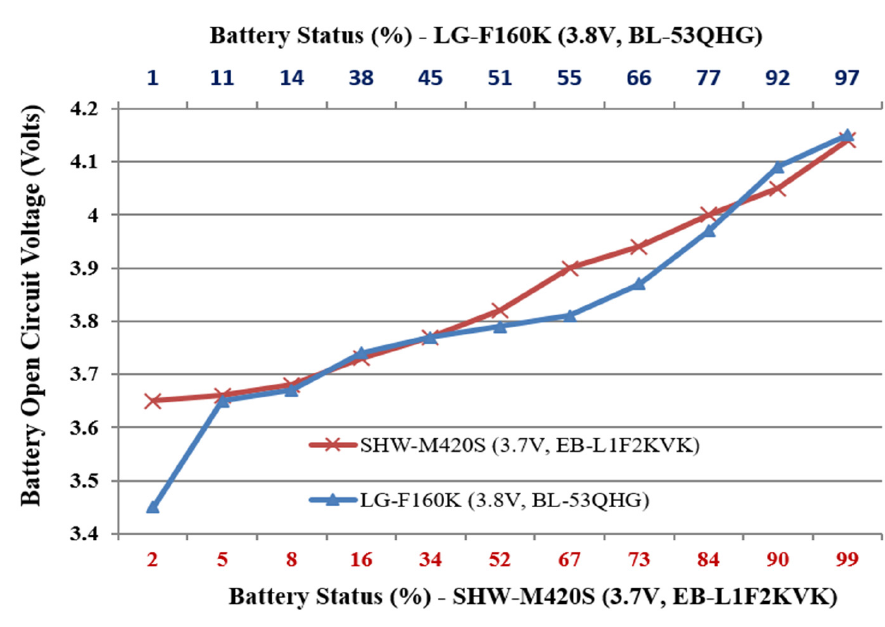
Figure 3. Two smartphones’ battery voltage w.r.t displayed battery status.